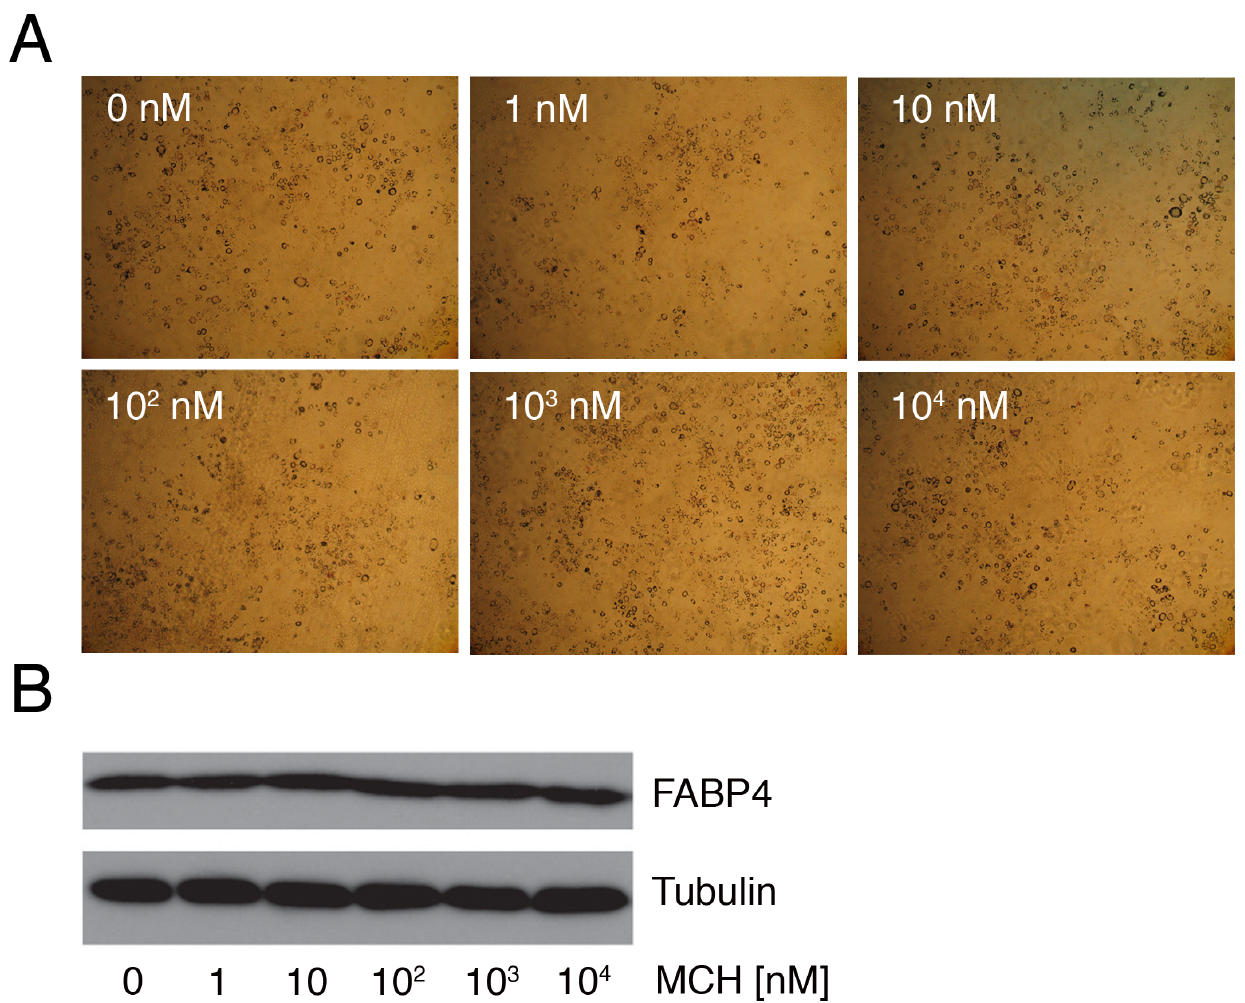
Figure 3. MCH does not modify invitro 3T3-L1 cell differentiation. ( A ) 3T3-L1 cell differentiation after 7-day administration of 1 nM, 10 nM, 100 nM, 1 m M, or 10 m M MCH as visualized by Oil-red-O staining (x20 magnification). ( B ) Western blot analysis for FABP4 (also known as aP2). Tubulin was used to control for input. Assays were performed in triplicate.